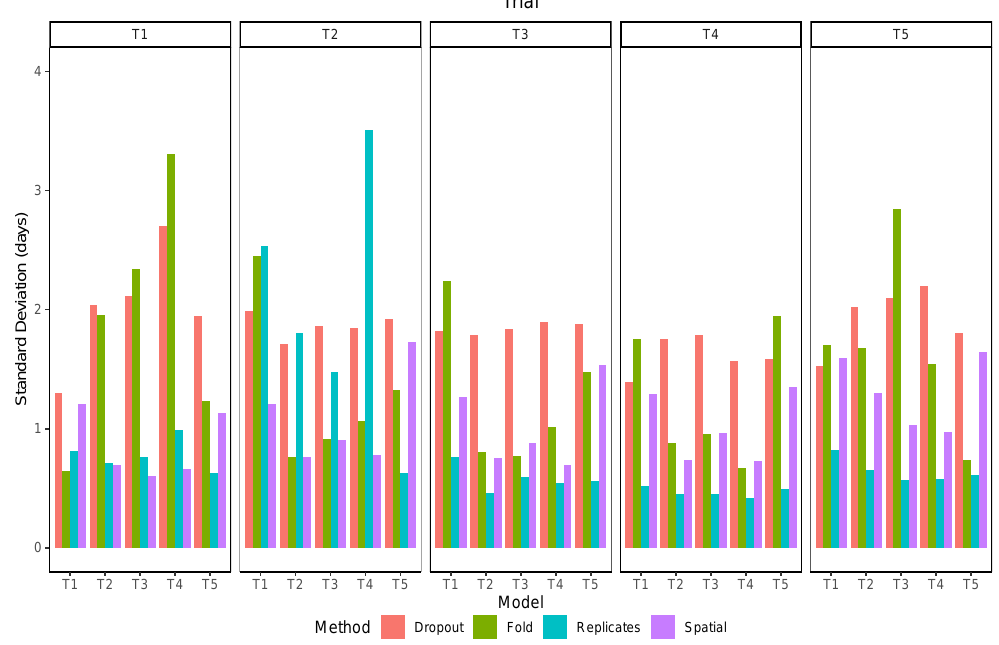
Figure 12. Standard deviation of maturity predictions using different methods to estimate uncertainty.